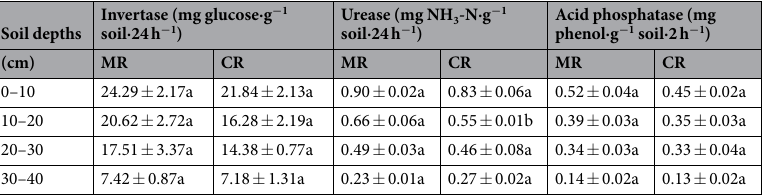
Table 2. Soil enzyme activity under different treatments. MR, rice monoculture model; CR, Integrated rice– crayfish model. Means with different letters for the same property in the same soil layer indicate significant differences at p < 0.05. Values are means ± standard errors.